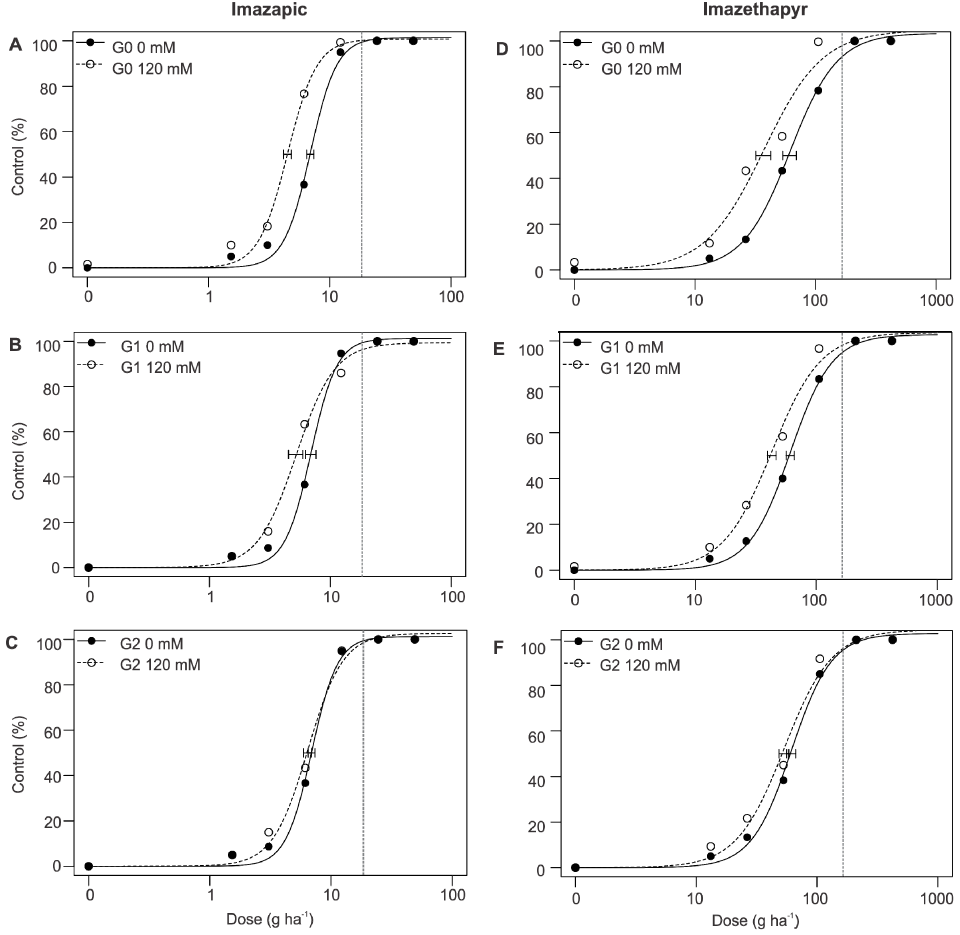
Figure 2. Nonlinear regression analysis of herbicide efficacy on Echinochloa colona as affected by cycles of recurrent exposure to salt stress and the sublethal dose of imidazolinone herbicides: response of E. colona from southern Brazil to imazapic (Kifix™, a formulated mixture of imazapic + imazapyr) in the parental population (G0) ( A ), G1 generation ( B ), and G2 generation ( C ). Also shown are the responses of E. colona from Arkansas, AR, USA to imazethapyr (Newpath™) of the parental population (G0) ( D ), G1 generation ( E ), and G2 generation ( F ). Circles (empty and filled) are the average of three replicates fitted with a three-parameter log-logistic model. Salt was applied at 120 mM. The vertical dotted gray lines indicate the recommended dose (g · ai · ha − 1 ). Agriculture 2020 , 10 , x FOR PEER REVIEW